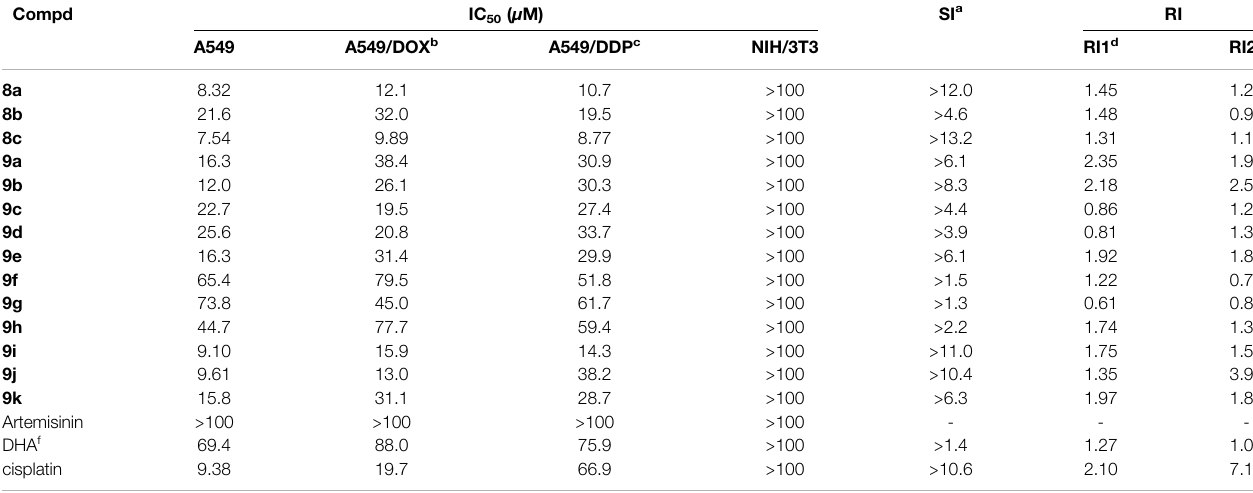
TABLE 2| Theantiproliferative activities,cytotoxicity,selectivityindexand resistanceindex valuesof1,2,3-triazole tethereddihydroartemisinin-isatinhybrids 8a-c and 9a-k .